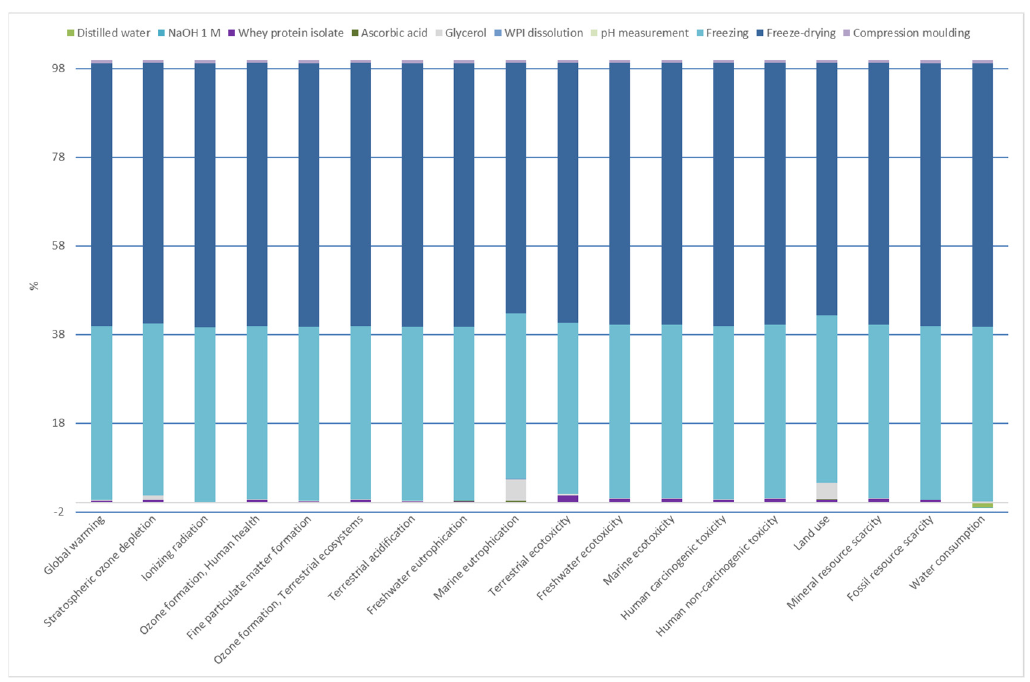
Figure 8. Relative contributions of each impact category for WPI film manufacture.